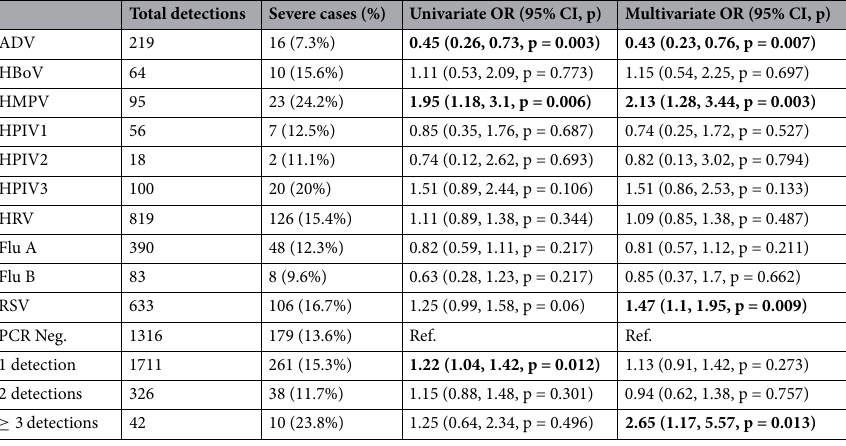
Table 3. Clinical severity by virus and number of detections. Table shows counts of hospitalizations with detections of Adenovirus (ADV), Bocavirus (HBoV), Human metapneumovirus (HMPV), H. parainfluenza 1 (HPIV1), H. parainfluenza 2 (HPIV2), H. parainfluenza 3 (HPIV3), Influenza A, Influenza B, Rhinovirus (HRV), and Respiratory syntitial virus (RSV), with the number of severe cases (defined as CSS > 3 ) for each virus. HPIV4 and H. coronavirus had no severe cases. The final two columns show the odds ratio for being a severe case (both mono- and coinfected) for the univariate model (virus only) as well as the multivariate model (adjusted for age, sex, smoking inside the child’s home, SES, calendar year, month of year, daycare attendance, and breastfeeding status). The comparator is all other cases without the focal virus. The bottom part of the table shows contributions to CSS by 1, 2, or ≥ 3 virus detections as compared to PCR negative patients. Estimates displayed in bold face indicate statistical significance (p<0.05).